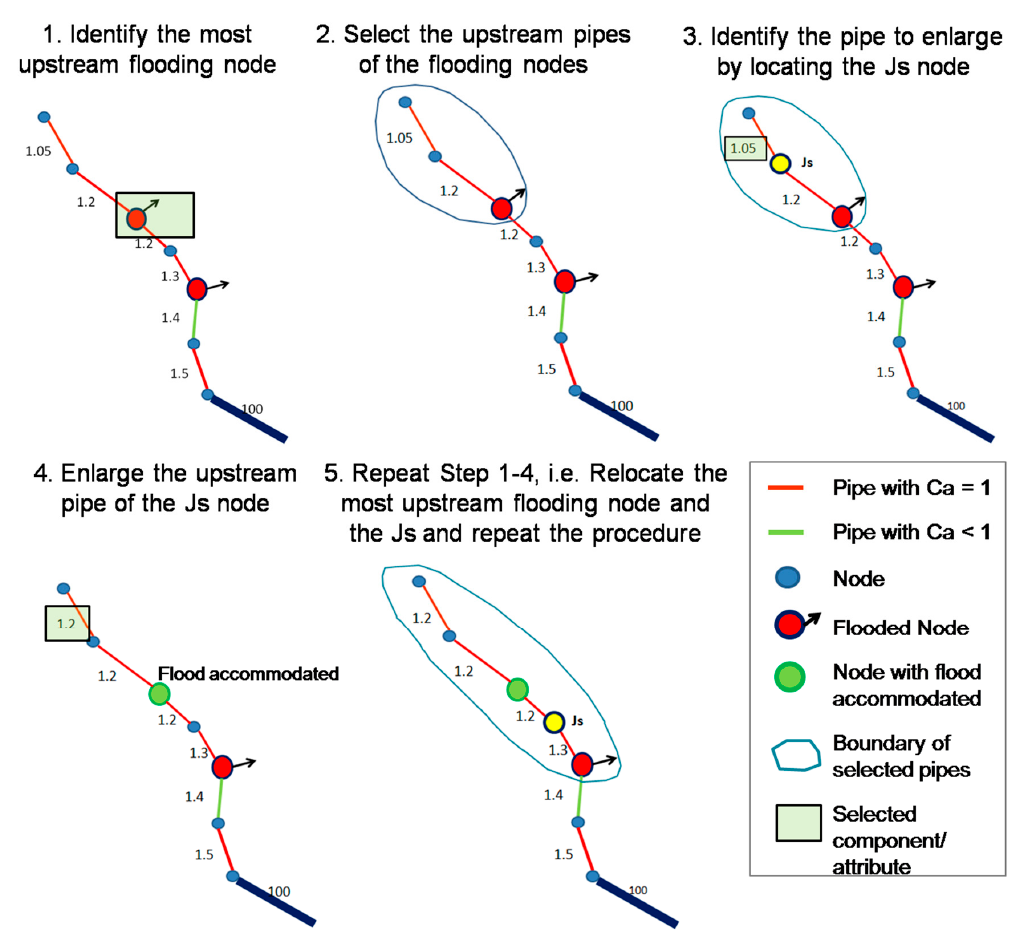
Figure 4. The pipe sizing procedure.